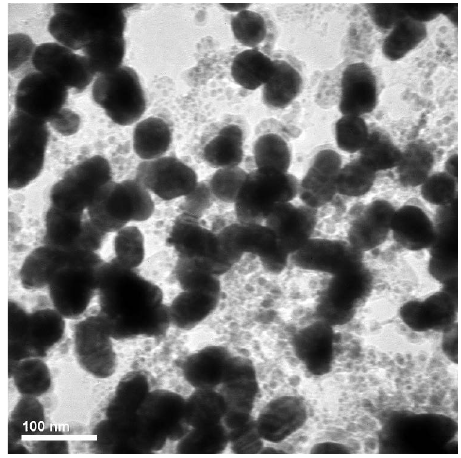
Fig. 11 Sub-10 nm AuNPs (5–8 nm) was observed in the as-synthesized 50 nm AuNP sample with the MR =